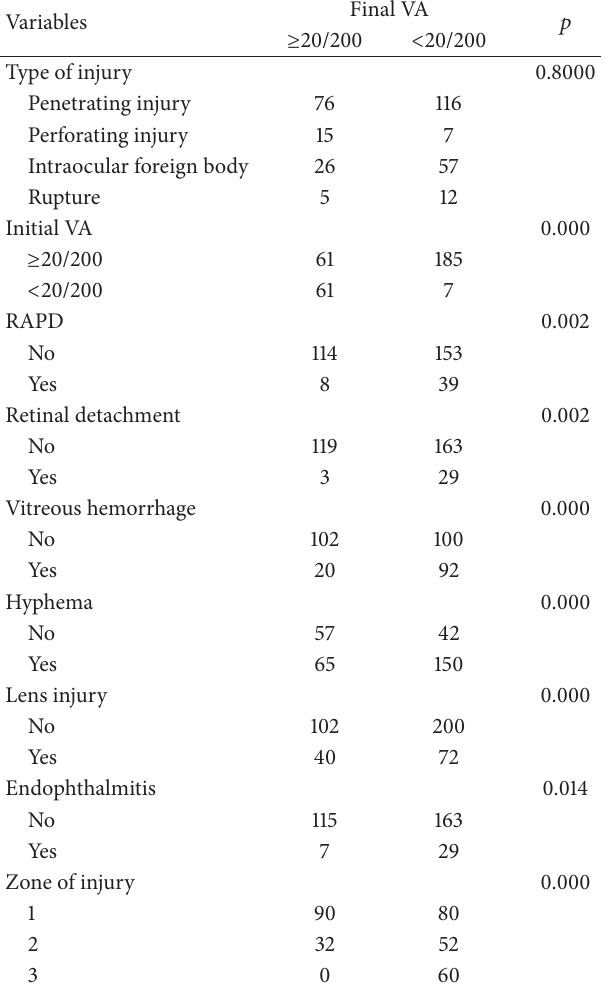
Table 3: Univariate logistic regression analysis of factors which affected final visual acuity.